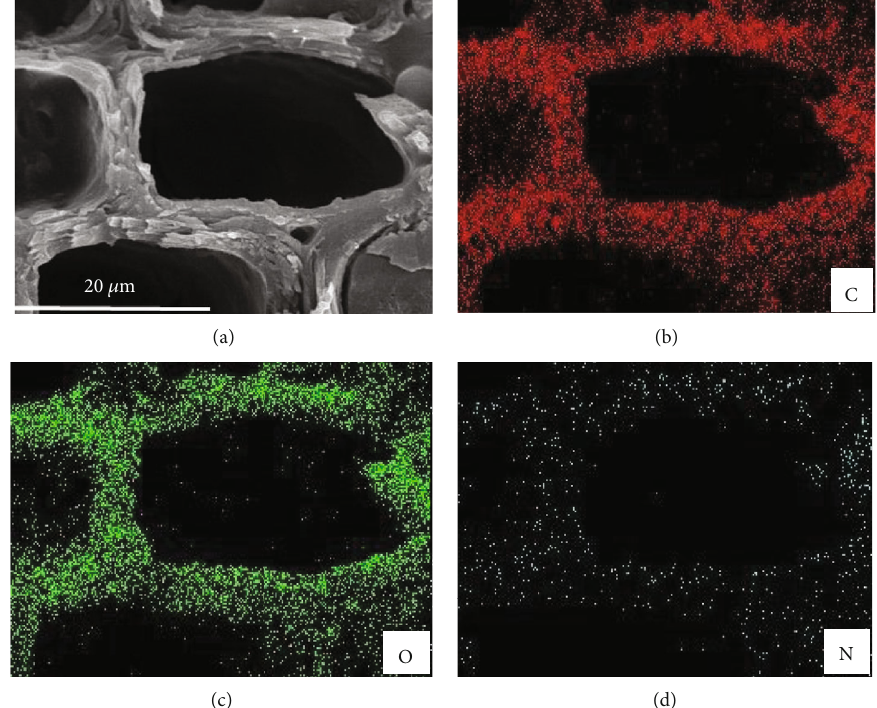
Figure 8: (a) SEM image of MUG-treated wood and EDX mapping showing the distribution of elements (b) carbon, (c) oxygen, and (d) nitrogen.